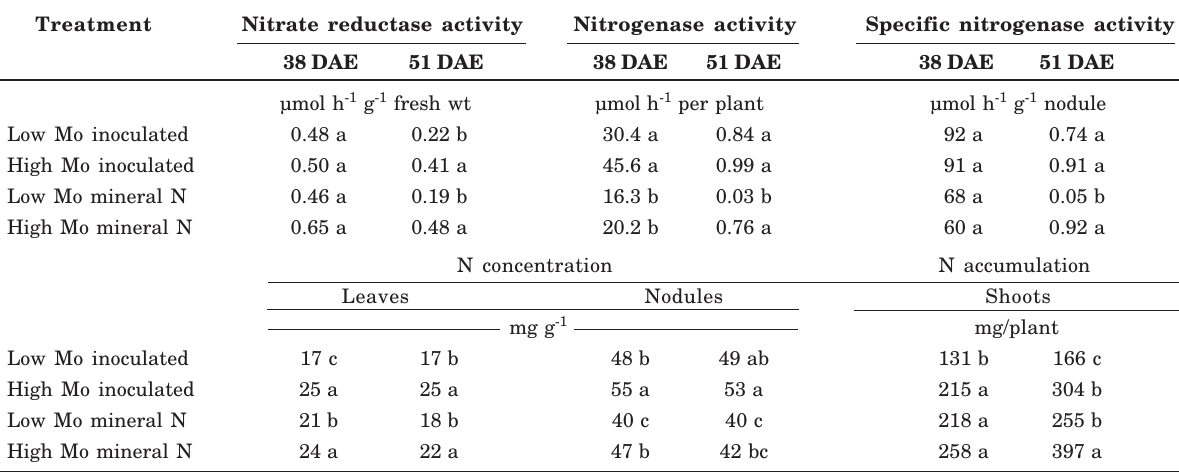
Means followed by the same letter in columns do not differ by Tukey’s test at